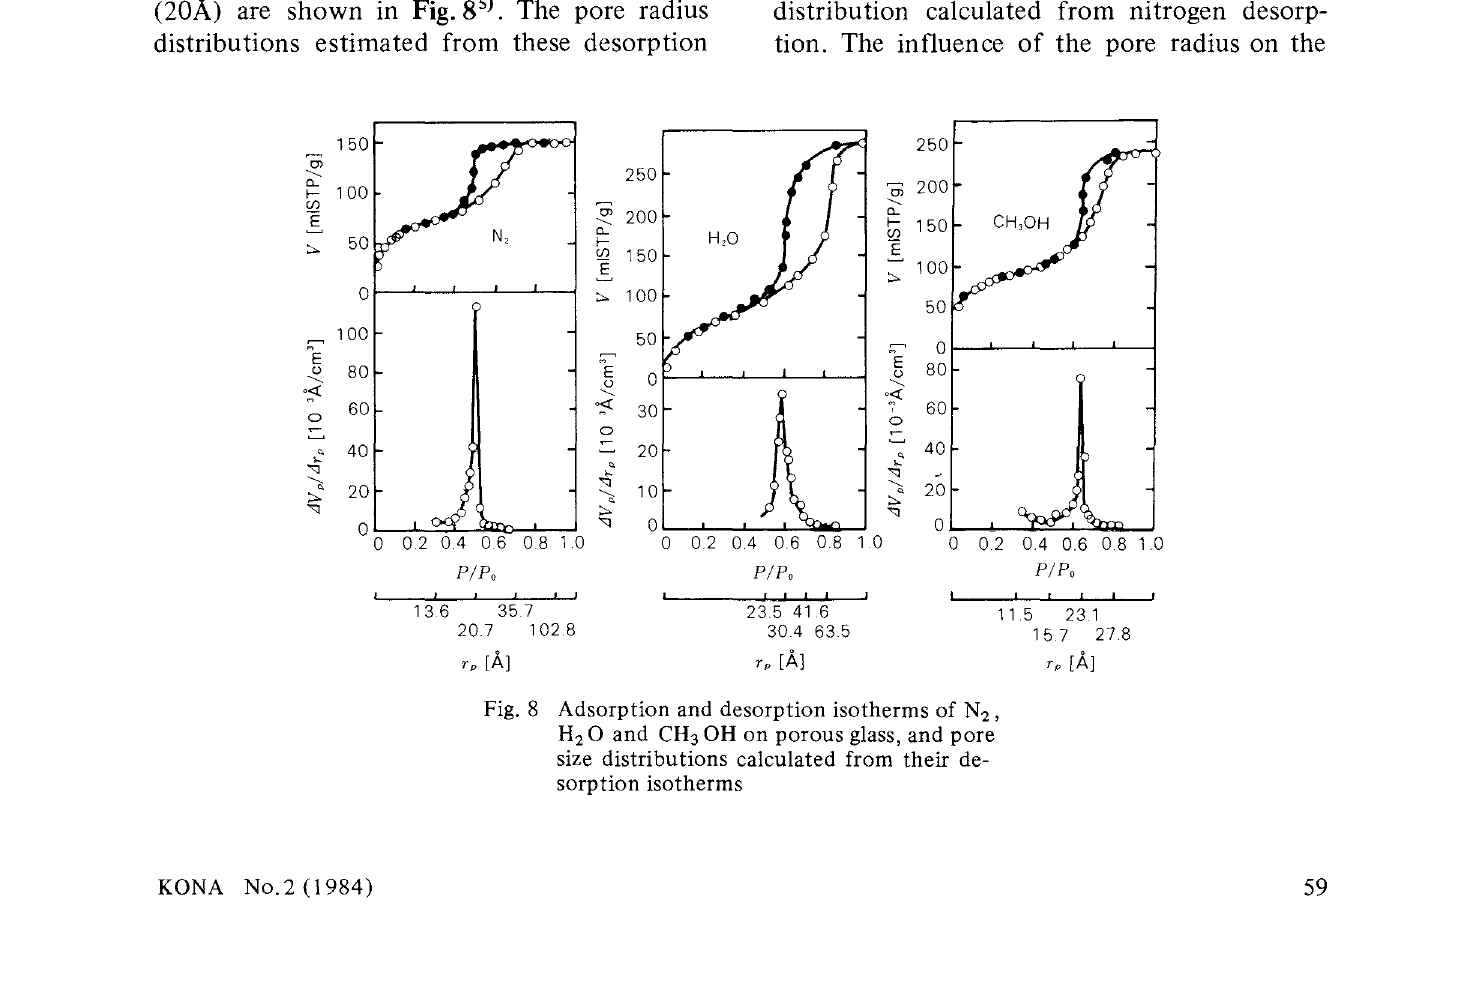
Fig. 8 Adsorption and desorption isotherms of N H 2 0 and CH 3 OH on porous glass, and pore size distributions calculated from their de sorption